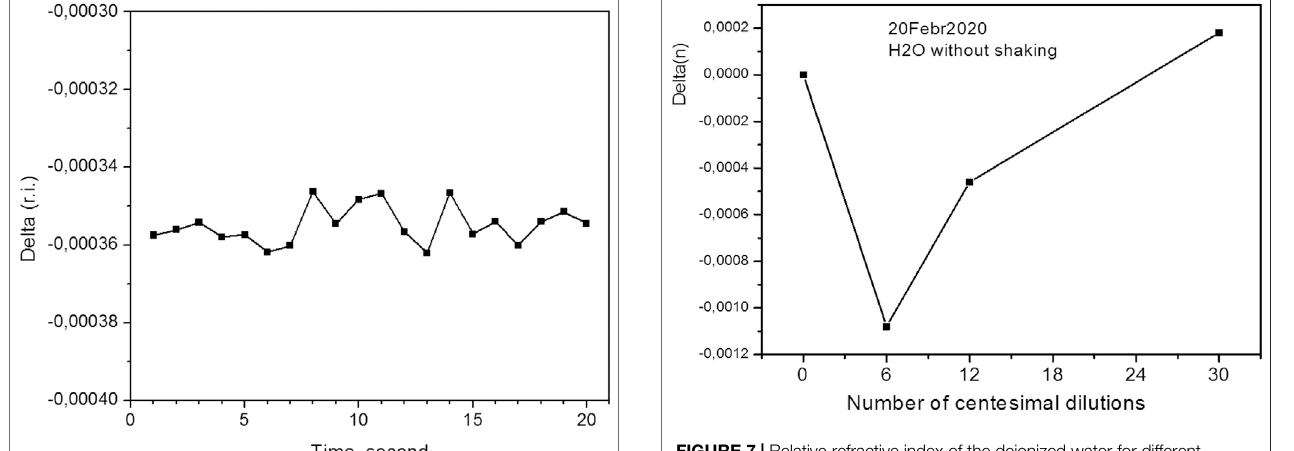
FIGURE 7 | Relative refractive index of the deionized water for different number of